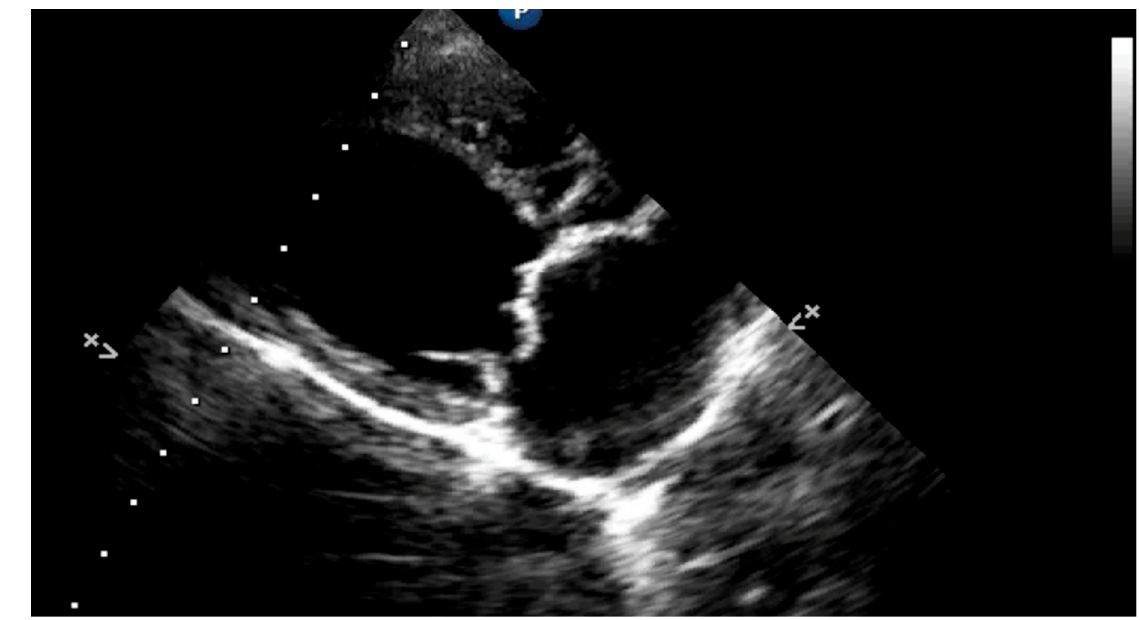
Figure 9. The presence of mitral valve septal leaflet prolapse is associated with tendinous chord rupture in the canine patient.